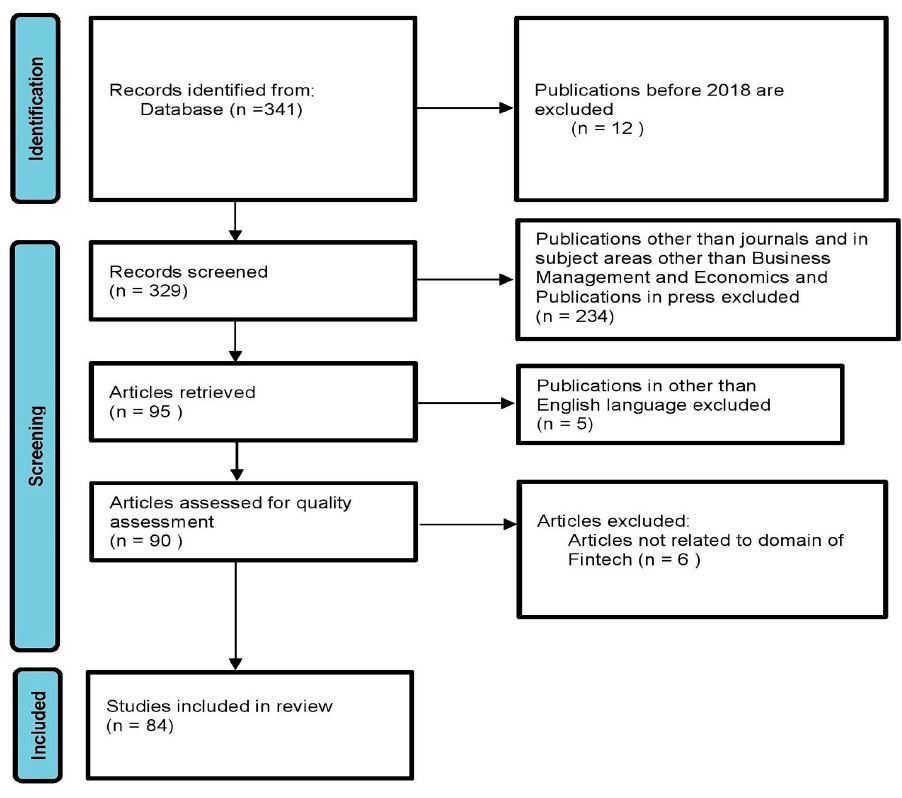
Figure 1. PRISMA 2020 Flow Diagram.